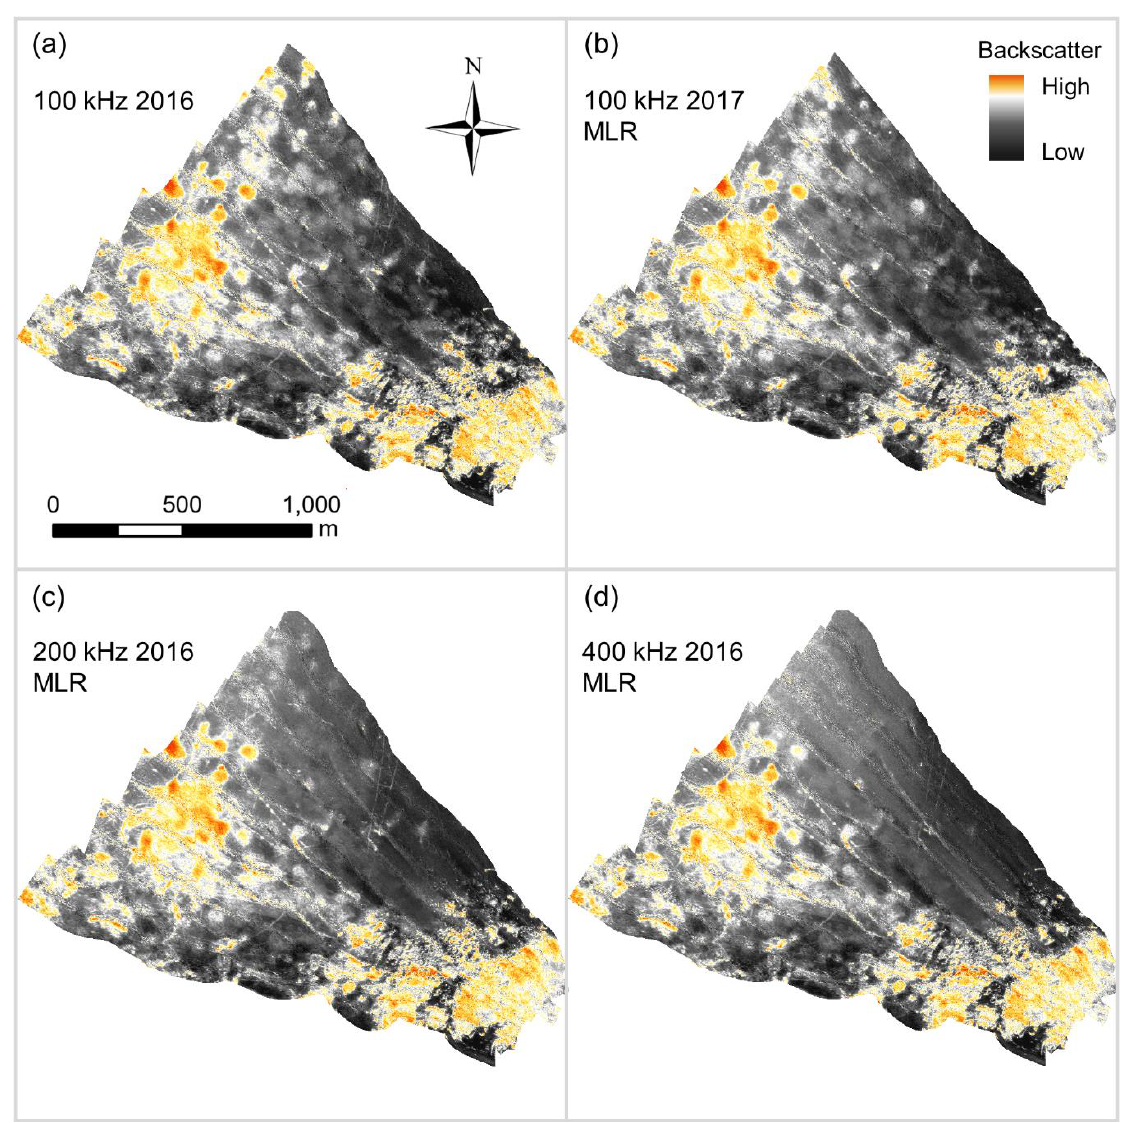
right panes for the Bedford Basin datasets are the 2017 data of the same frequency, corrected to the 2016 data. Bottom panes for all figures are multi-frequency bulk shift mosaics. Remote Sens. 2020 , 12 , x FOR PEER REVIEW